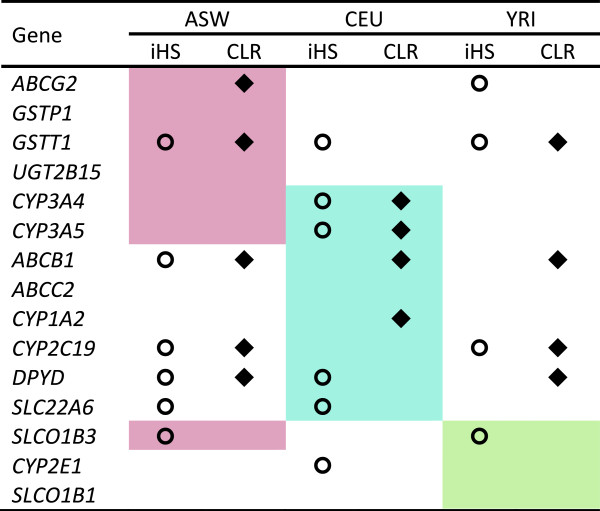
LSBL analysis and natural selection testing of the ADME core genes. Brown represents the genes with significant LASW, blue represents genes with significant LCEU, and green represents significant LYRI. The diamond symbol represents the genes with significant CLR scores, whereas the cycle symbol represents the genes with significant iHS scores.